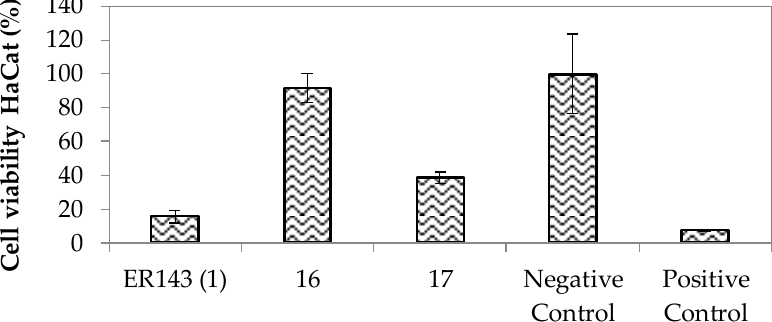
Figure 2. Cell viability assay at 50 µM concentration of fluorescent compounds ER143 (1) , 16 and 17 in HaCaT cells for 24 h of exposition time.